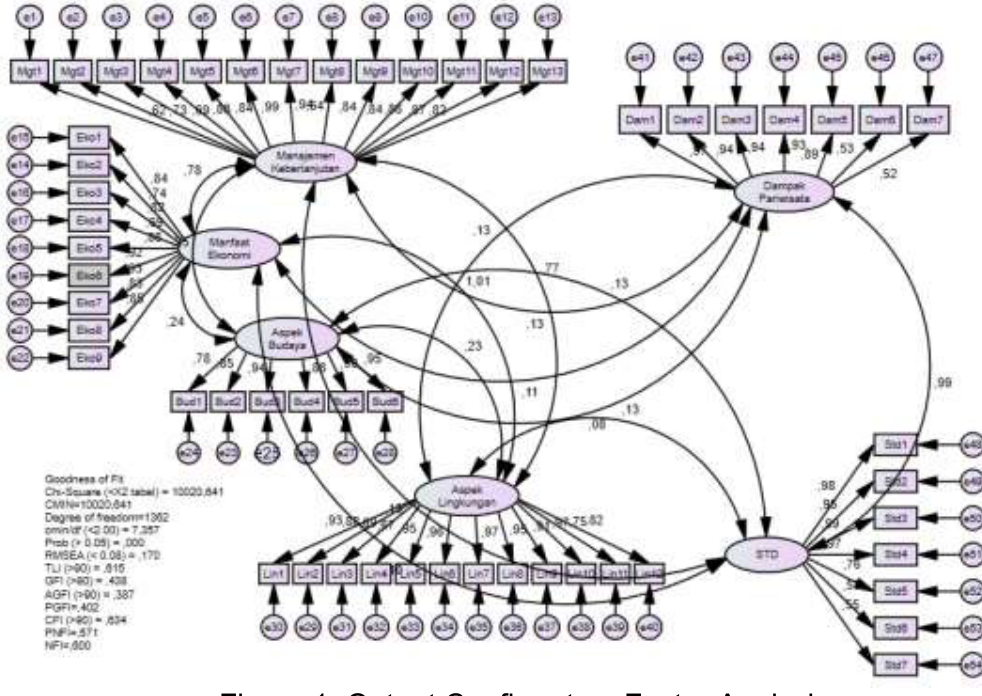
Figure 1. Output Confirmatory Factor